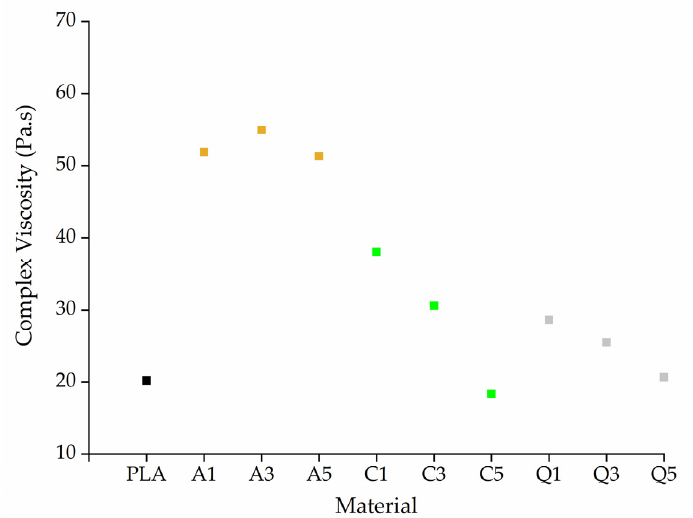
Figure 15. Complex viscosity of melt-electrospun fibers formed of PLA and its composites contain-